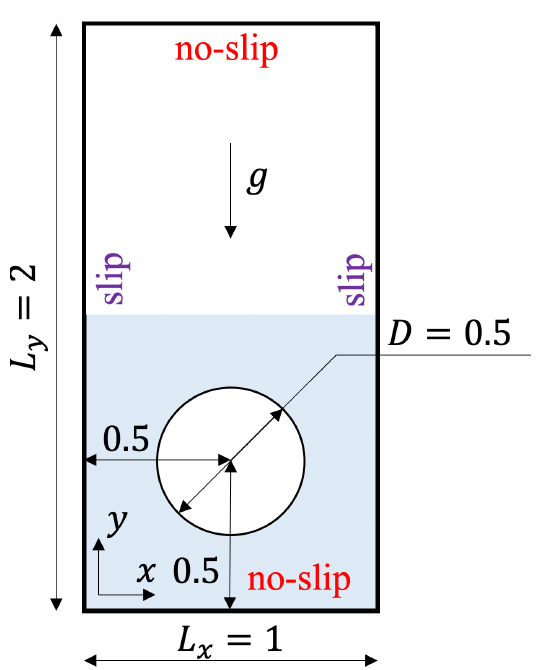
Figure 14. A schematic diagram of liquid film generation and rupture simulation by a single bubble freely rising to an interface. The region presented in light blue is occupied by heavy fluid and the region presented in white is occupied by light